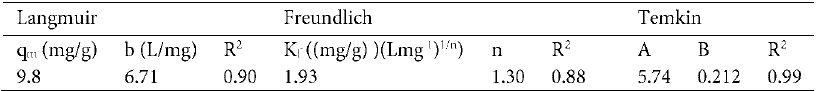
Table 3. Langmuir, Freundlich and Temkin constants for adsorption of MB on 5-SA-TiO2 at 25